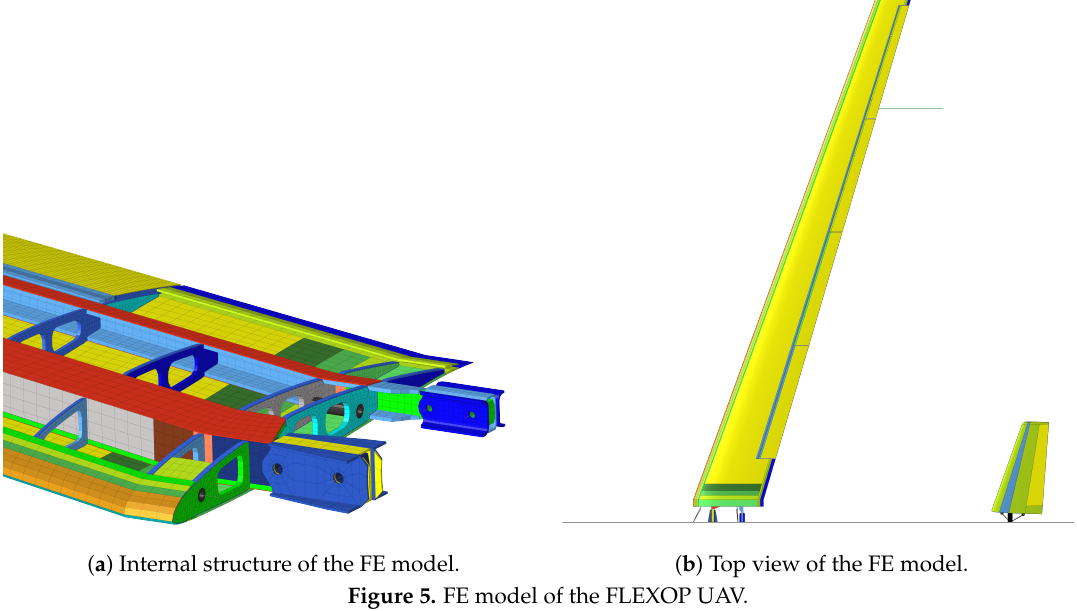
Figure 5. FE model of the FLEXOP UAV.